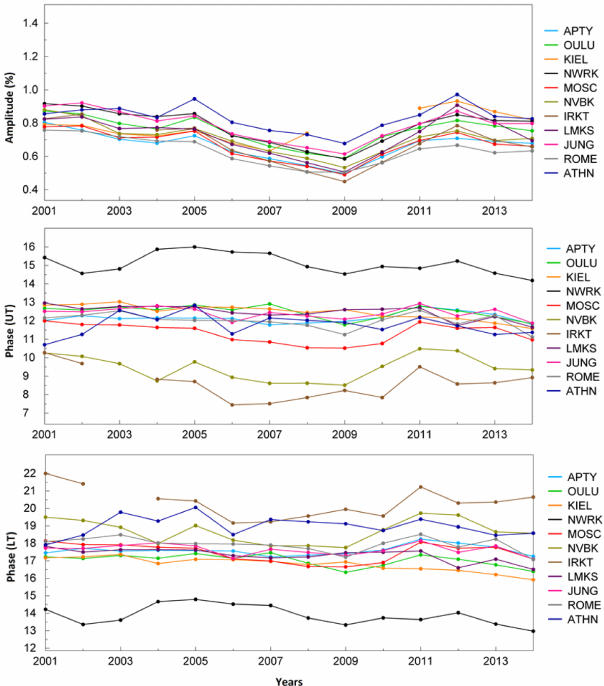
Figure 5. Time profiles of the diurnal amplitude (upper panel) and the time of maximum in UT and LT (middle and lower panels) of all the stations for the years